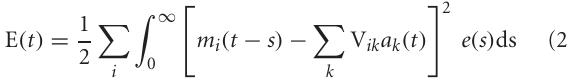
for simplicity. Thus, after alignment of motor activity and sensory response with song (green arrows), in the case of a causal inverse, the mirroring offset (cid:3) t defined as the time lag between motor activity and playback response (red bar with extension set by red dashed lines) is equal to the sensory feedback delay τ = τ m + τ a , whereas in the case of a predictive inverse the mirroring offset (cid:3) t is close to 0. The reason for the 0 offset associated with a predictive inverse is that the auditory burst a 1 driving the playback response m a 2 is selective to the sound feature that during singing was generated by the much earlier burst m 1 in a different neuron (black burst in (A) , right panel), but not the feature generated by m 2 (blue burst in (A) , right